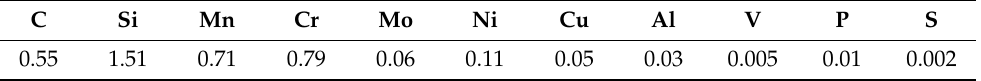
Table 1. Chemical composition of the experimental steel (wt.%), balance